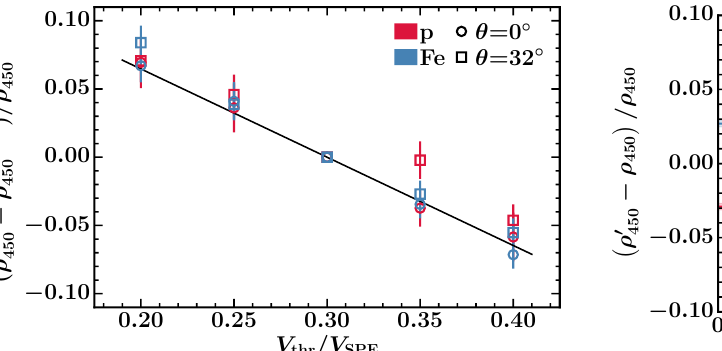
val- Figure 6: Relative di ff erence of the reconstructed muon 450 densities ρ (cid:48) for soil densities ρ soil ± 3 σ ρ compared to 450 soil ρ 450 obtained for ρ soil in bins of shower zenith angle θ . Dashed lines correspond to the relative di ff erence aver- aged over all zenith angles, shaded bands the correspond- ing standard error of the mean. Numbers at the bottom state the number of events in each zenith bin.